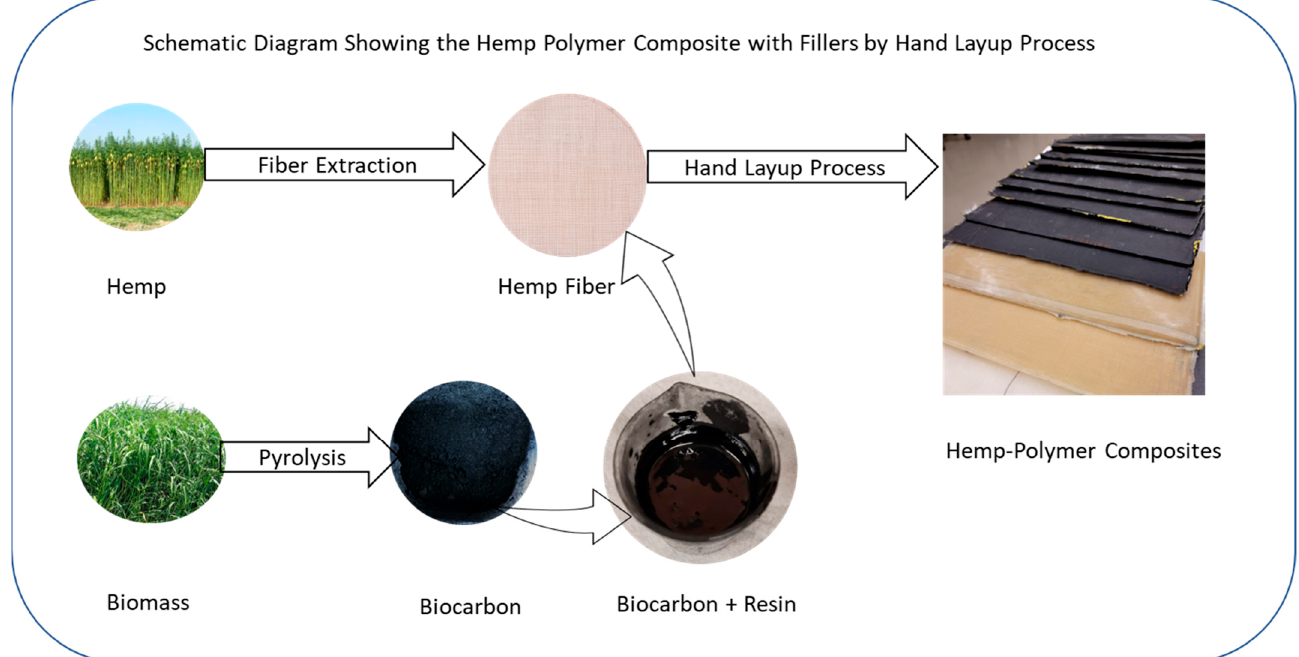
Figure 1. Showing the schematic of the preparation of hemp-polymer composites with fillers by hand layup technique. layup